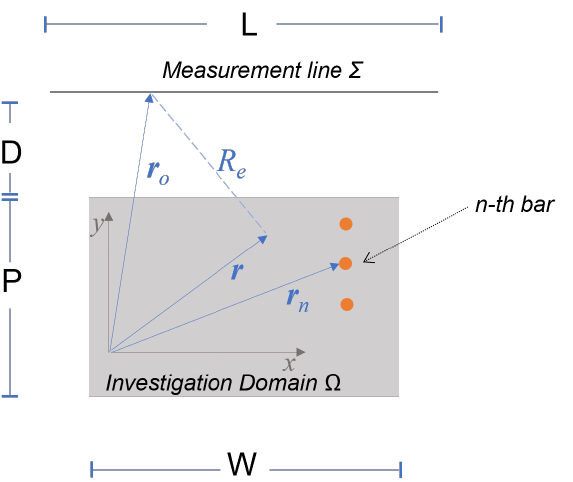
Figure 1. Geometry of the problem and reference system. The investigation domain is the rectangle of size W × P placed at distance D from the measurement line, whose length is L